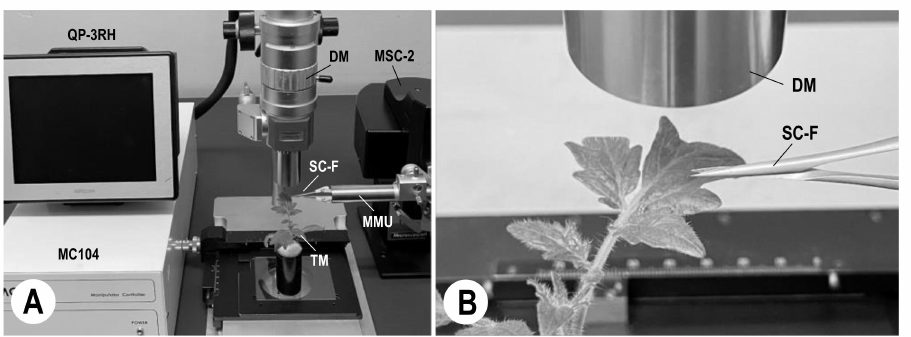
Figure 1. Single KTP-03-inoculated tomato leaf type I trichome collection system combining digital microscopy and micromanipulation techniques. ( A ) A 14-day-old tomato seedling TM was placed under a KH-2700 digital microscope (DM). Precision scissors (microscissors) (SC-F) inserted into the microscissors main unit (MMU) were installed in the manipulator (MSC-2). After powering the motion controller (MC104), the single trichome cells were cut using SC-F microscissors by operating